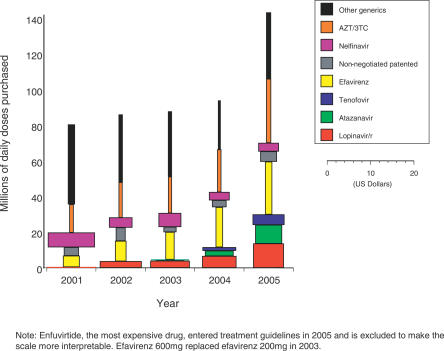
Contributions of Drug Price and Purchase Quantities to Total Cost, 2001–2005The overall contribution of a particular drug to total costs in a given year is represented by the area of the rectangle that represents that drug. Changes in quantities for a particular drug appear as changes in the height of the rectangle. Changes in the price per daily dose of each ARV appear as changes in the width of the bars. The values associated with the width of the bars are reflected in the legend. The overall height of the bars in each year reflects the estimated total number of doses purchased in that year.